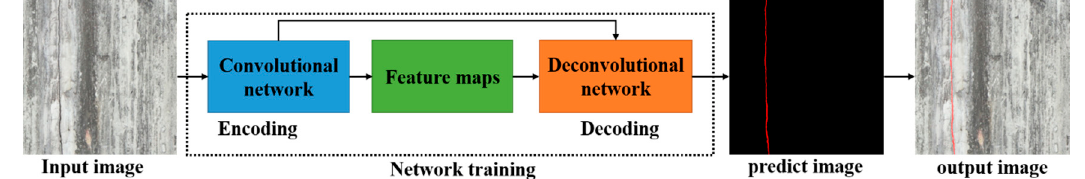
Figure 1. The diagram of crack detection network.